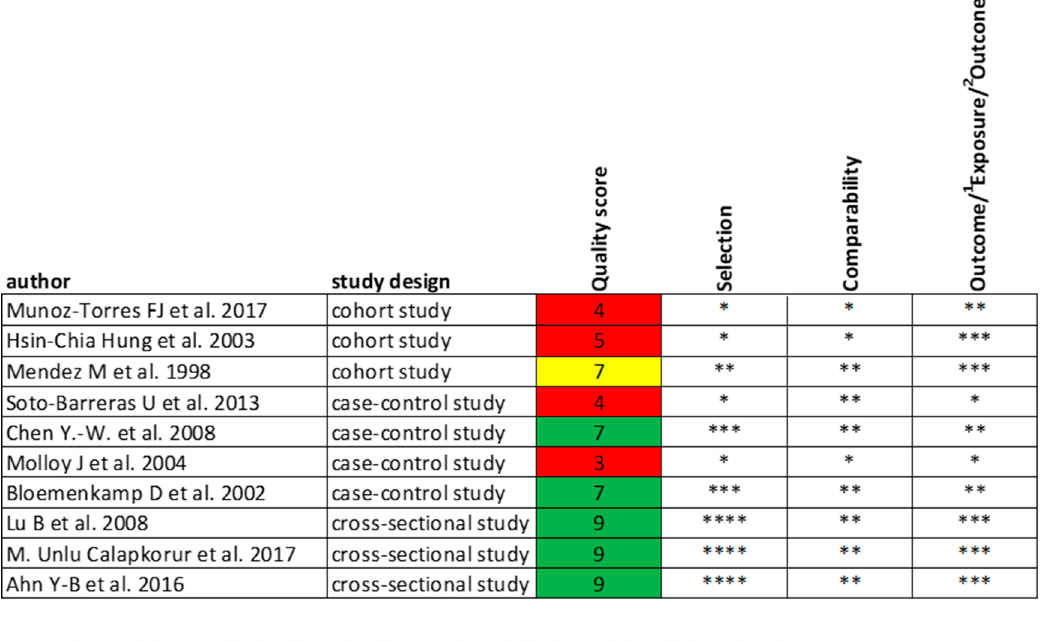
Figure 4. Results of the quality assessment.